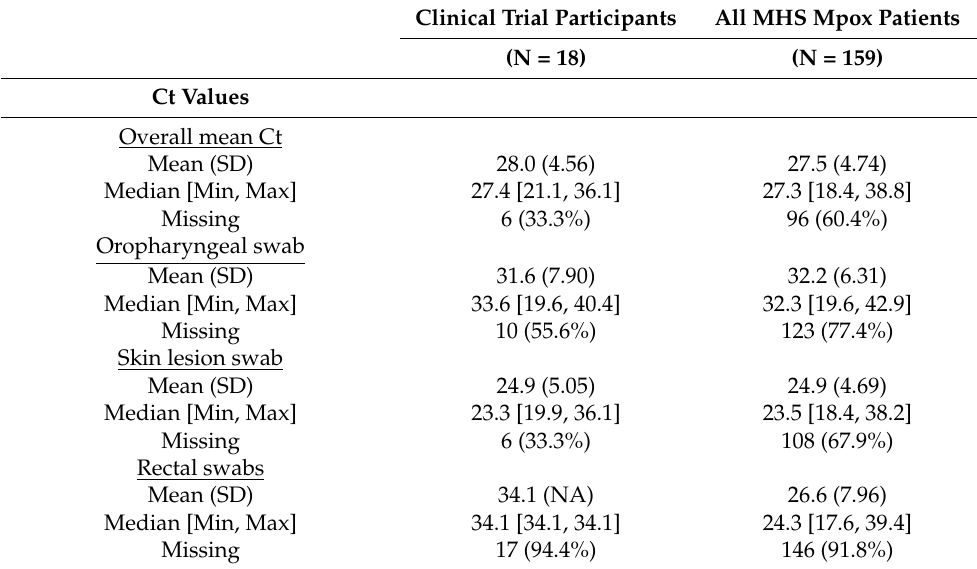
Table 2. MPXV PCR Ct value results of swabs from different anatomical